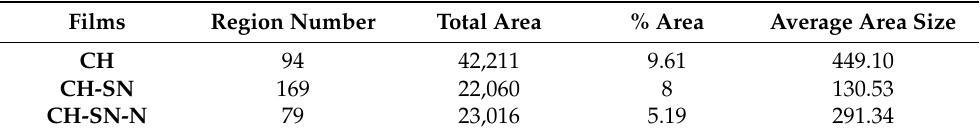
Table 4. Comparison of the morphological characteristics.